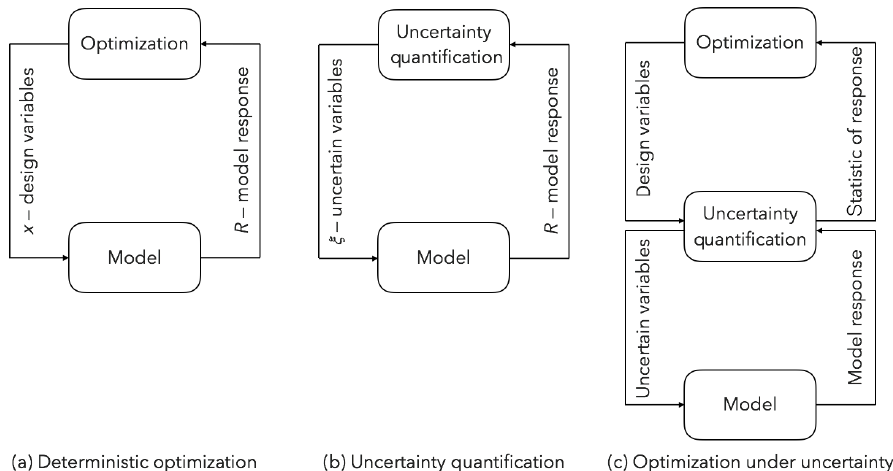
Figure 1. Examples of applications that require many model evaluations. In deterministic optimization (a) , we evaluate the model at different values of the design variables while searching for an optimum response. In uncertainty quantification (b) , we query the model multiple times at different instances of the uncertain variables to generate an ensemble of responses from which we can compute statistics and probabilities of the model response. In optimization under uncertainty (OUU), we optimize a statistic. OUU is computationally expensive as it requires many model evaluations because of the nested loop in the problem formulation (c)